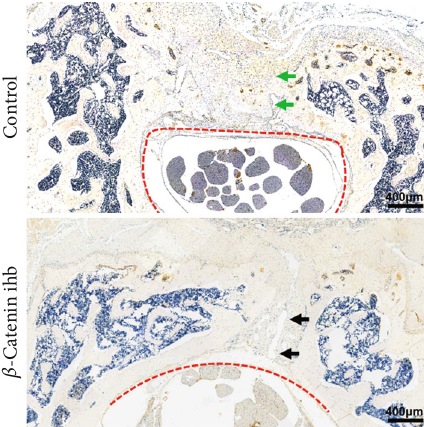
Figure 6: IHC staining of OCN at the 14th week. Green arrow indicates the newborn complete vertebral laminae in the control group, black arrow indicates the lamina defect in the β -catenin inhibition group, and red dish line indicates the vertebral